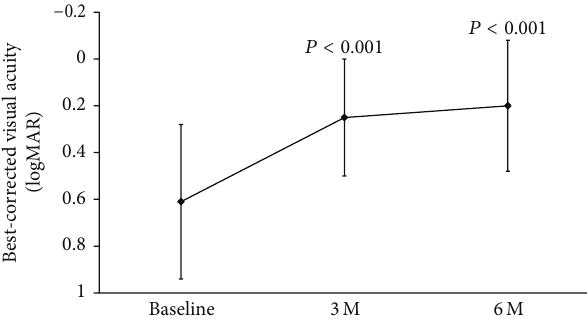
Figure 2: Changes of the best-corrected visual acuity (BCVA) up to 6 months after the MH surgery. BCVA is significantly improved after the initial surgery with ILM peeling at 3 and 6 months postoperatively ( 𝑃 < 0.001 and 𝑃 < 0.001 , Mann-Whitney test).